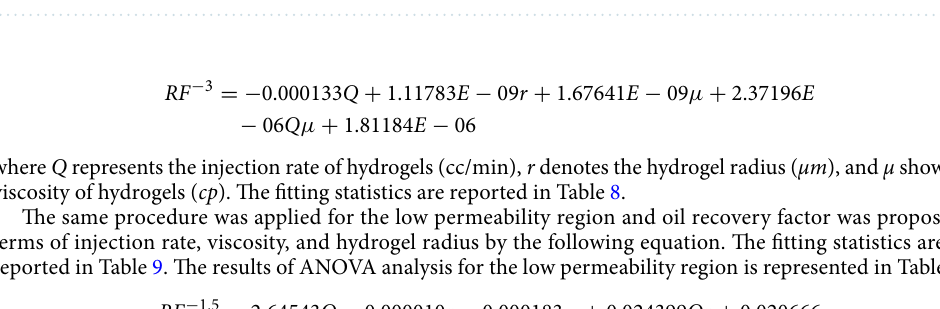
Table 7. ANOVA Analysis for the recovery factor in high permeability region.